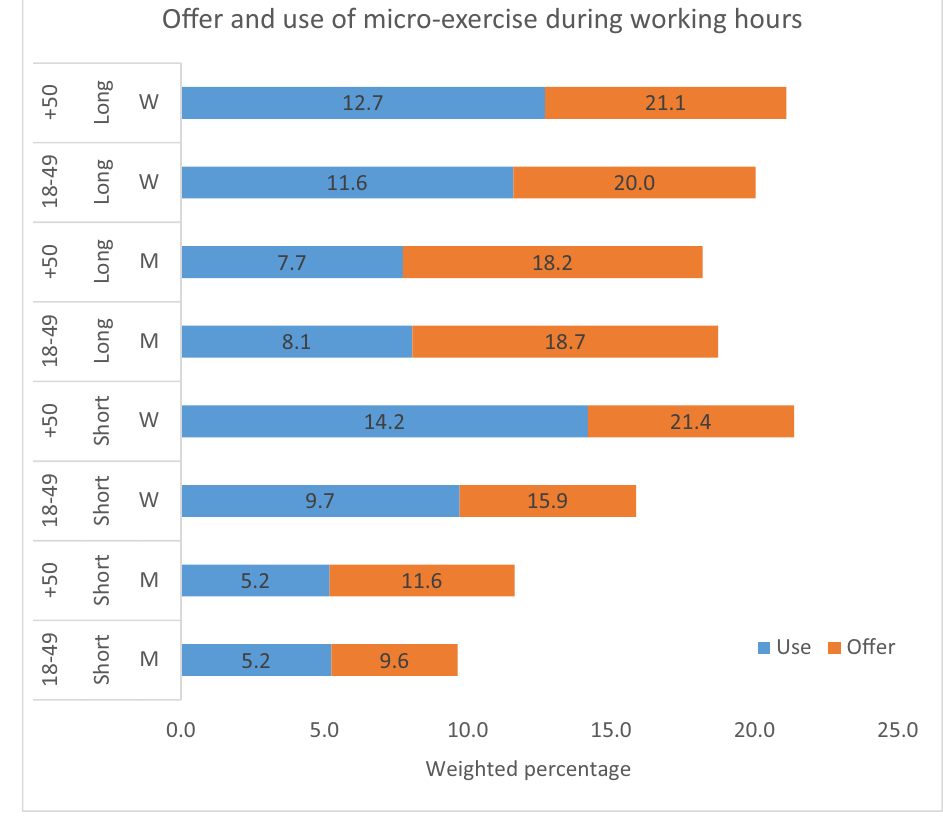
Figure 2. Offer and use of micro-exercise during working hours (weighted percentages) across different strata of education (Short = unskilled and skilled, Long = further education), sex (W = women, M = men) and age (18–49, + 50 years). Data pooled for the years 2012, 2014, 2016 and 2018.